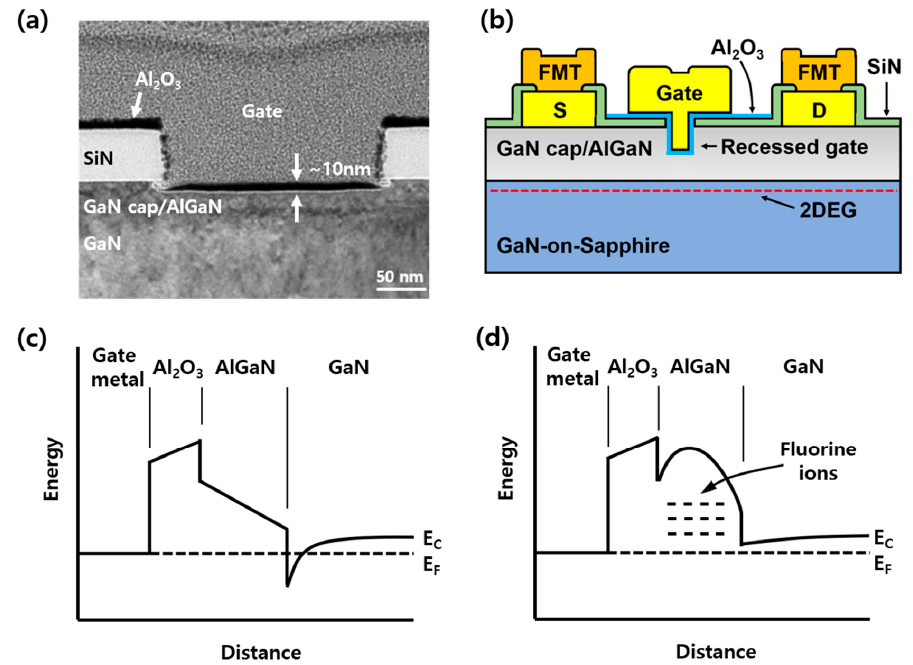
Figure 1. The fabricated AlGaN / GaN MIS-HEMTs on sapphire substrate. Recessed gate was formed under gate region for V T modulation. ( a ) The TEM image of the recessed gate. The AlGaN layer was etched by the digital etch process in 15 cycles. ( b ) Schematic cross-section of the processed device. ( c ) Band diagram of MIS-HEMTs under equilibrium condition. ( d ) Band diagram of MIS-HEMTs after CF 4 treatment under equilibrium condition.